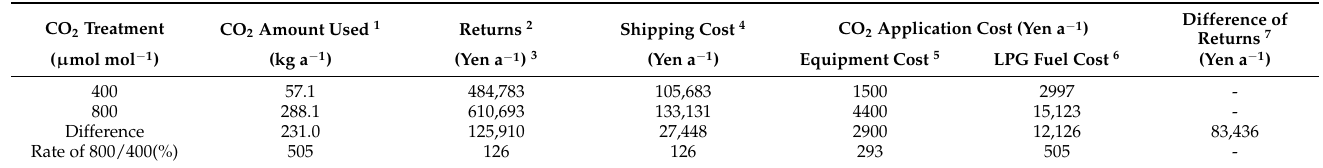
Table 2. Economic value of strawberry ‘Sagahonoka’ cultivated at different CO 2 concentrations.